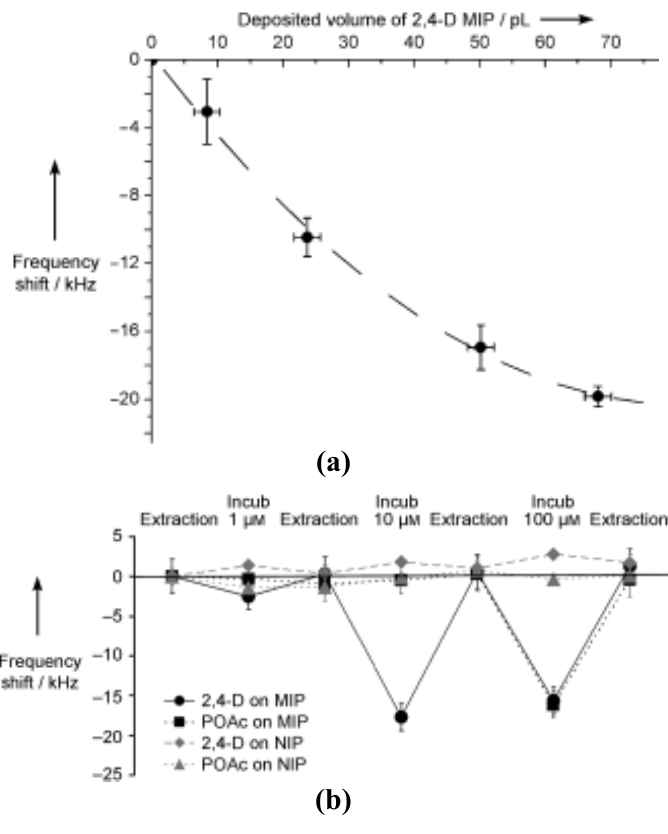
Figure 8. ( a ) Influence of the reduced volume of MIP on the resonance frequency of the array after rebinding of 2,4-D; ( b ) Detection of the rebinding of 2,4-D and POAc at increasing concentrations on a 2,4-D MIP and a